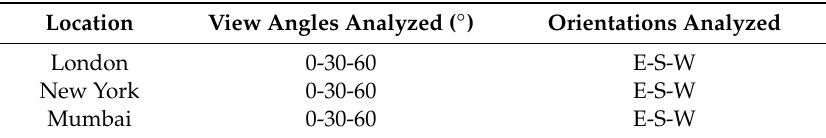
Figure 2. Three-step process for the calculation of the temperature gradient in glasses.